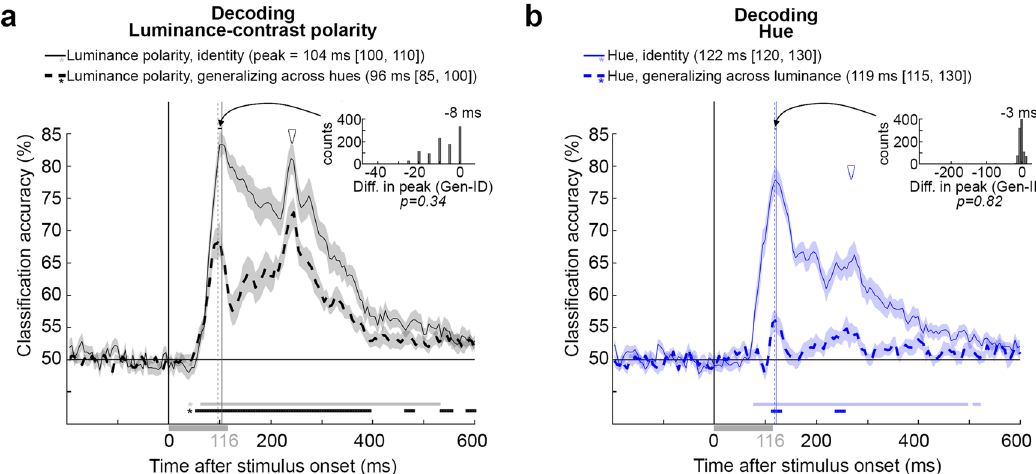
Fig. 3 Decoding luminance polarity and hue from MEG data: results. a Classi fi cation accuracy as a function of time after stimulus onset for the luminance- polarity problems (center of error shading shows the average of identity problems, solid line; average of generalization problems, dashed line). Traces were generated by averaging 1000 bootstrapped samples across 18 participants. Shading shows the SE of the bootstrap samples. The stimulus duration was 116ms (gray bar). Inset shows the difference in peak for the 1000 bootstrapped comparisons: identity minus generalization (mean = − 8 ms, p = 0.34; one-sided test of the proportion of these differences that was less than or equal to zero, not corrected for multiple comparisons). Initial peak of the identity problems, solid vertical gray line, 104.4ms [100, 110]; initial peak of the generalization problems, dashed gray line, 96.5ms [85, 100]. Open arrowhead shows the second decoding peak, which corresponds to stimulus cessation. The horizontal sequence of data points above the x -axis, demarcated by asterisks, show time points at which decoding was above chance (determined by a permutation test across subjects and cluster corrected, see “ Methods ” section); onset of signi fi cant decoding for the identity problems was achieved at 65ms [60, 80], and for the generalization problems at 55ms [50, 70]. b The average performance across 12 sets of identity problems (solid line) and 12 sets of generalization problems (dashed line). The inset shows the difference in peak (for the 1000 bootstrapped comparisons across participants, identity minus generalization, mean = − 3ms, p = 0.82, proportion of differences that was less than or equal to zero, not corrected for multiple comparisons). The time to peak was the same for the identity and generalization problems (identity problems: solid vertical line, 121.8ms [120, 130]; generalization problems: dashed vertical line, 119.1ms [115, 130]). Onset of signi fi cant decoding for the identity problems was achieved at 80 ms [75, 85], and for the generalization problems, at 115 [35, 355]. Other conventions as for panel b